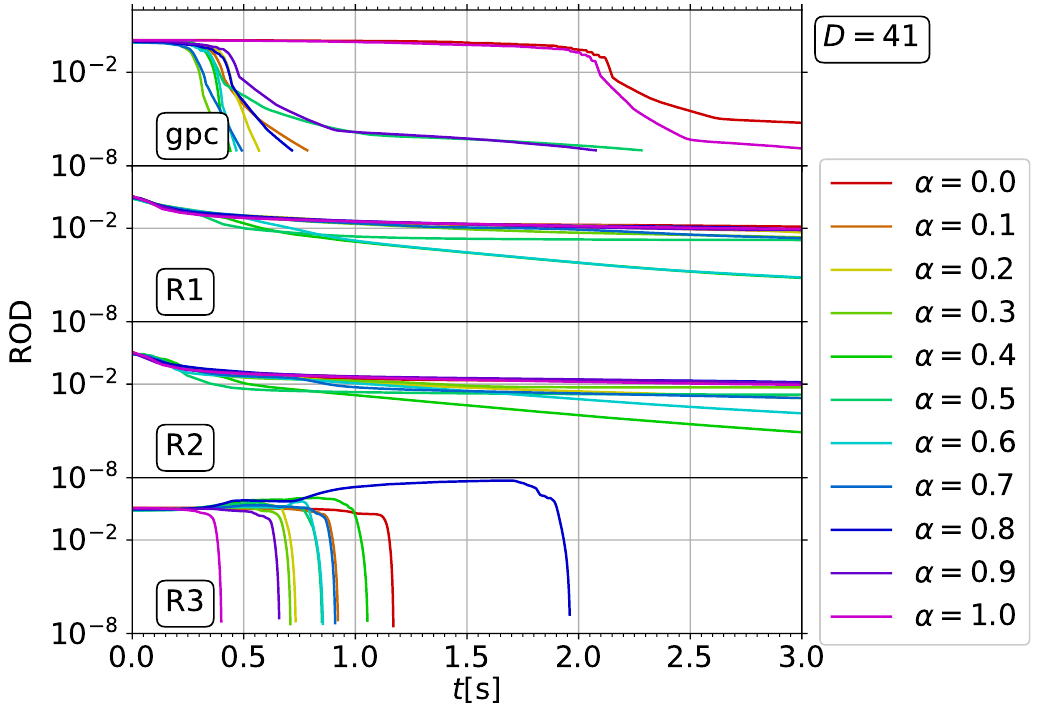
Figure 3: ROD flow vs. time for D -dimensional random matrices, see Sec. 4.3.2, and various crossover ratios α induced by the gpc-generator in comparison to flows induced by the R1-, R2- and